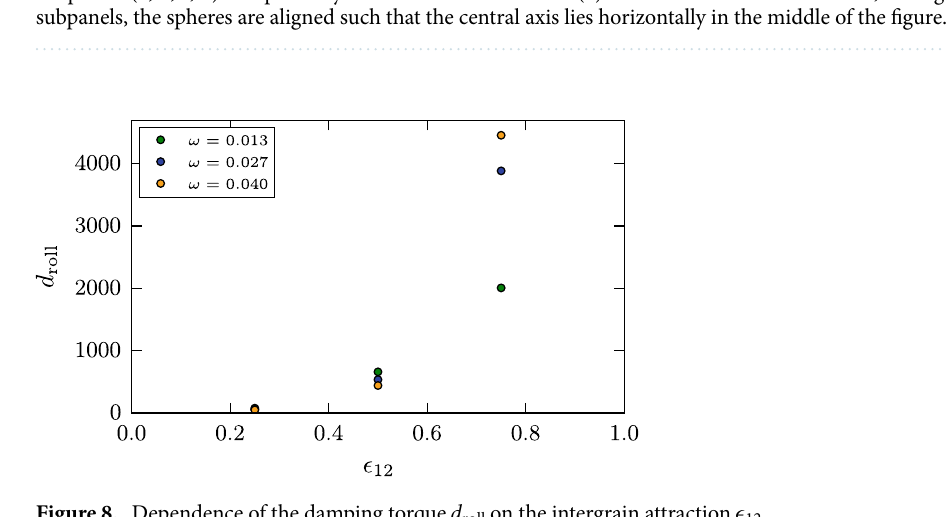
Figure 8. Dependence of the damping torque d roll on the intergrain attraction ǫ 12